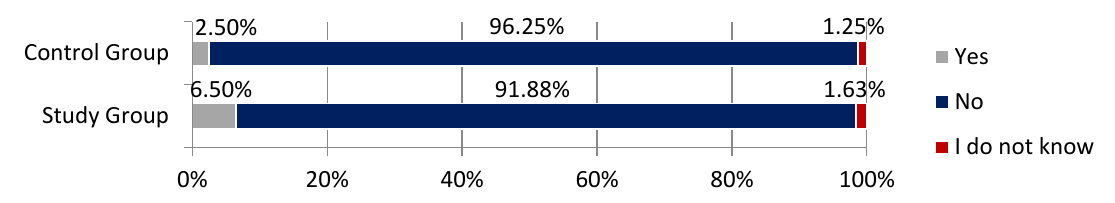
Figure 3. Hospital admission in the previous 12 months due to chest pain or myocardial infarction (MI).